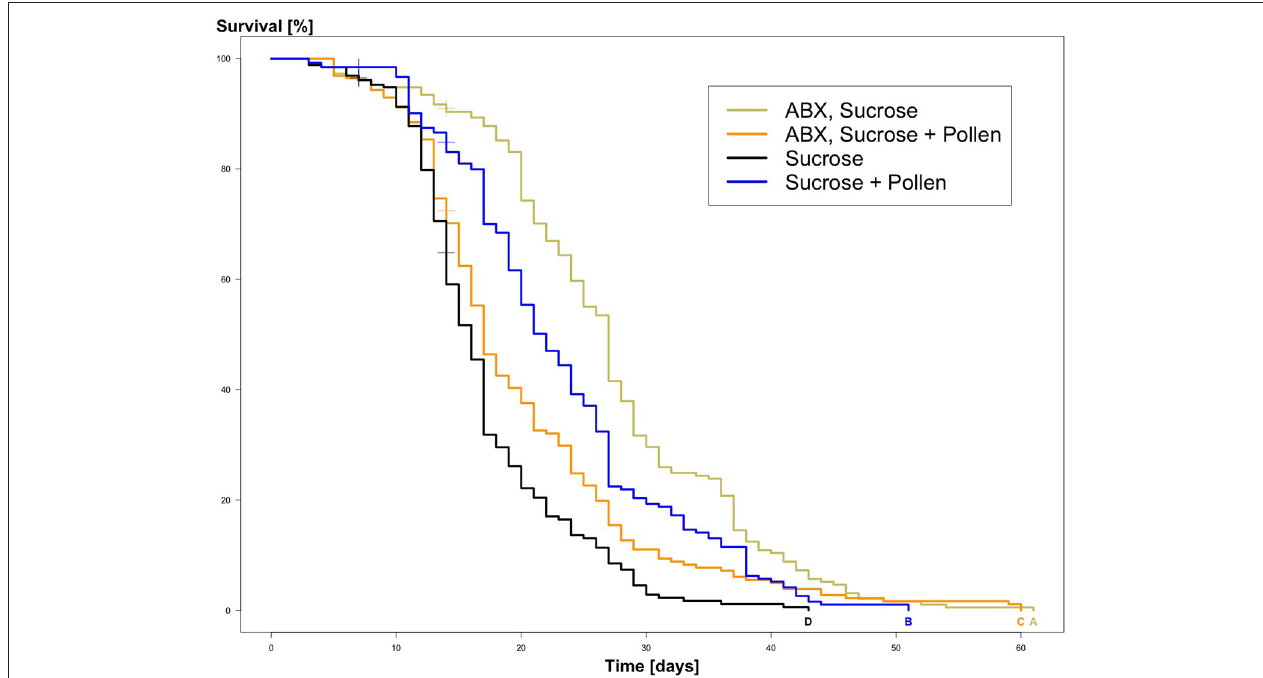
FIGURE 1 | Kaplan Meier Survival curves of experimental adult workers, Apis mellifera , from the four treatment groups: ABX + Sucrose, ABX + Sucrose + Pollen, Sucrose, Sucrose + Pollen ( N = 260 workers per group). Significant differences between the survival of the experimental workers are indicated by compact letter display based on log rank tests and Bonferroni p -adjusted values ( P s < 0.05).